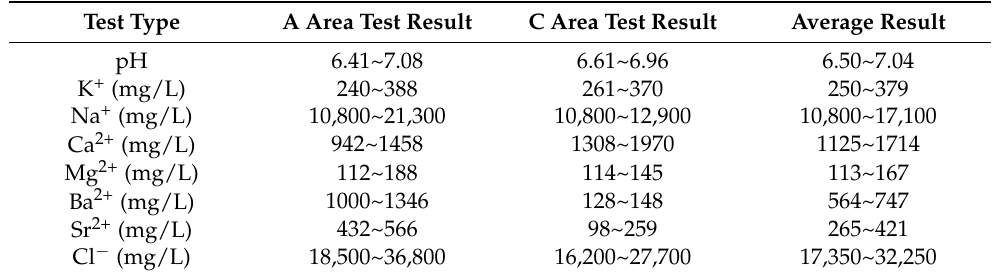
Table 1. Geochemical parameters of produced water from a shale gas field in southwest